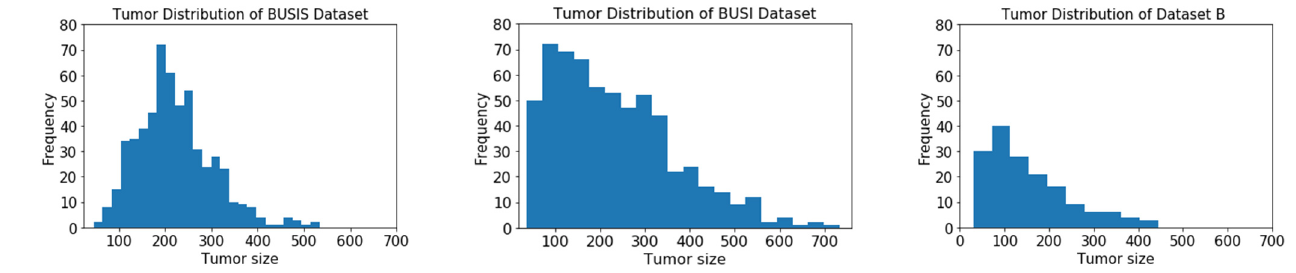
Figure 4. Histogram of tumor sizes (number of